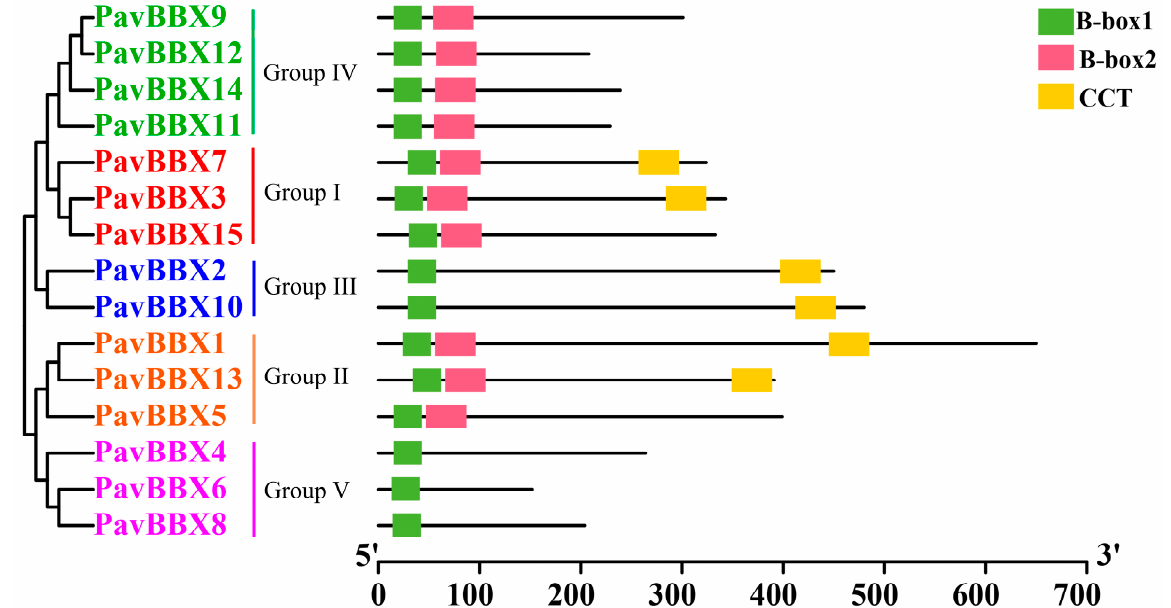
Figure 1. Structures of Prunus avium BBX proteins. The green, pink, and yellow rectangles represent the B-Box1, B-Box2, and CCT domains, respectively. The scale bar represents amino acids.